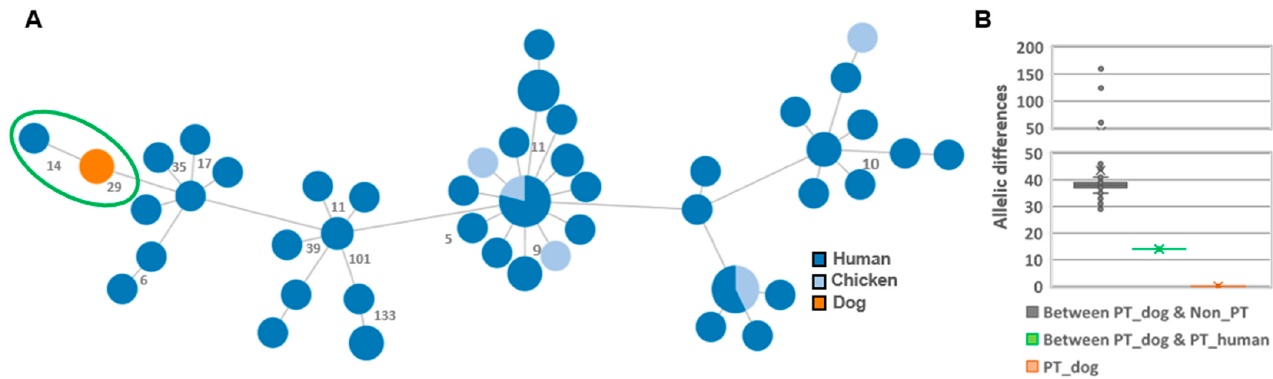
Figure 3. Genomic relatedness among Campylobacter jejuni ST-6461 strains based on a dynamic gene-by-gene approach using a wgMLST schema with 2795 loci. ( A ) The Minimum spanning tree was constructed using the goeBURST algorithm implemented in the PHYLOViZ online platform and is based on the allelic diversity found among the 1011 genes shared by 100% of the validated strains. Filled circles (nodes) represent unique allelic profiles, and are colored according to strains’ source (human, chicken, or dog). The size of nodes is proportional to the number of isolates it represents. Portuguese strains are marked with a green circle: three isolates from dogs (PT_Cj-Br2/1, PT_Cj-Br7/2, PT_Cj-Br8/1) and one from human (PT_Cj-4010). The numbers in grey on the connecting lines represent the allele differences (AD) between strains. For better visualization, only AD ≥ 5 are shown. ( B ) Box plot depicting the AD (including the median values) within and between PT strains from dogs and the remainder.